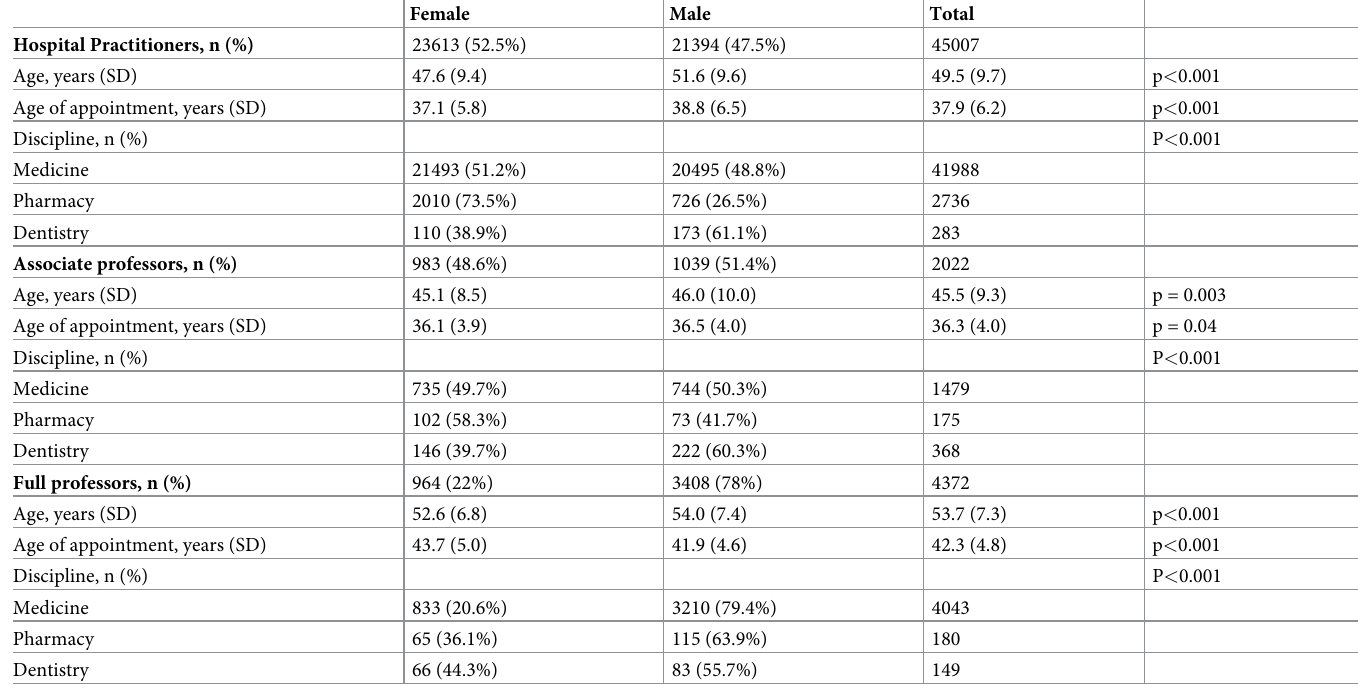
Table 1. Demographic characteristics of French public hospital doctors in